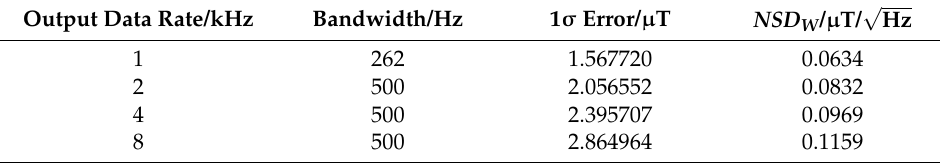
Table 4. Broadband noise performance figures for the indicated